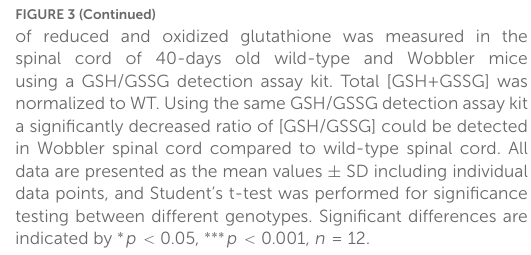
FIGURE3(Continued) of reduced and oxidized glutathione was measured in the spinal cord of 40-days old wild-type and Wobbler mice using a GSH/GSSG detection assay kit. Total [GSH+GSSG] was normalized to WT. Using the same GSH/GSSG detection assay